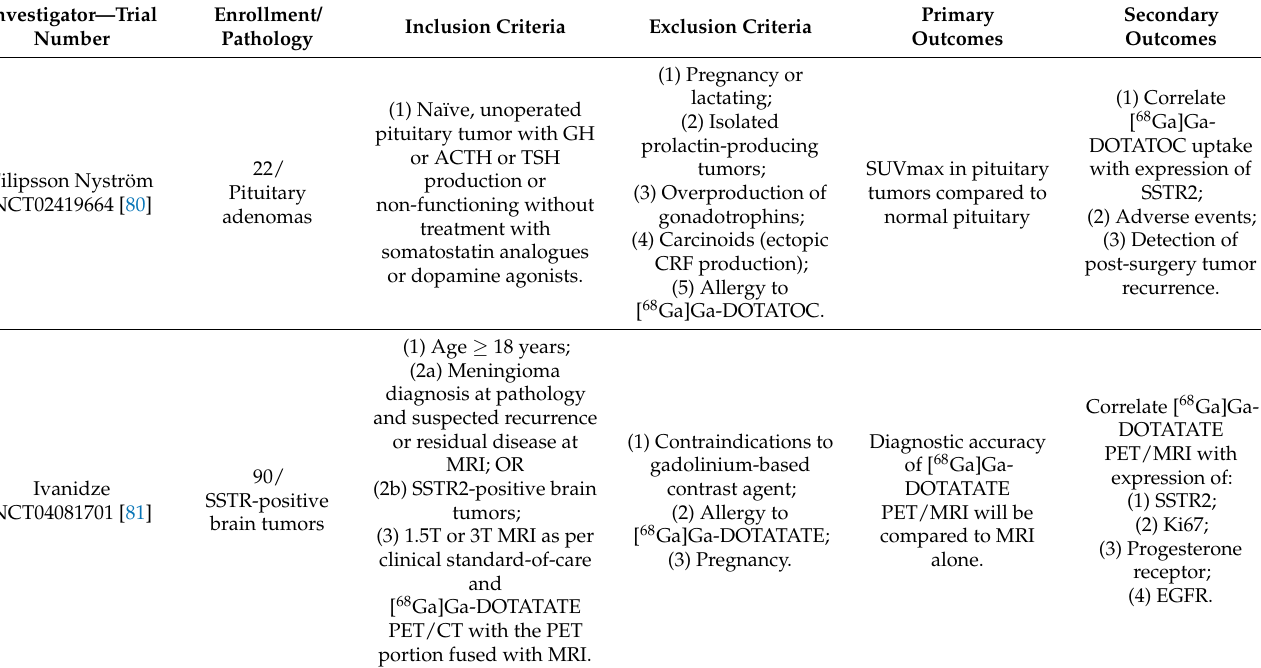
Table 5. Overview of all ongoing clinical trials on [ 68 Ga]Ga-DOTA-SSTR PET in